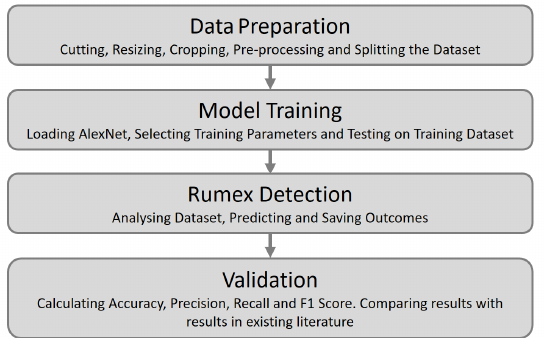
Figure 2. Flowchart of the main steps taken to execute and validate the approach